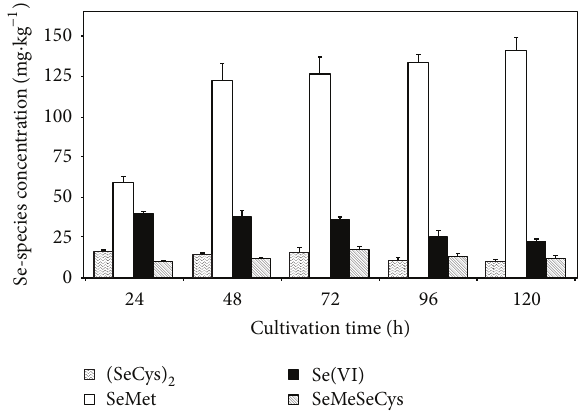
Figure 8: Selenium species concentration in Chlorella sorokiniana dry biomass (mg ⋅ kg −1 ) in function of cultivation time for culture exposed to 40mg ⋅ L −1 selenate in culture medium. During culti- vation 750 mL of culture volume was collected daily from each replicate bottle and centrifuged to obtain sufficient biomass to perform the necessary analyses. Data are given as mean values of at least three measurements ± S.D. of the means. Average difference between repeated measurements did not exceed 5% as can be seen from standard deviation indicators. The difference SeMet = selenomethionine; (SeCys) 2 = selenocystine; SeMeSeCys = 2− ) Se-methylselenocysteine; and Se(+VI) = selenate ( SeO 4